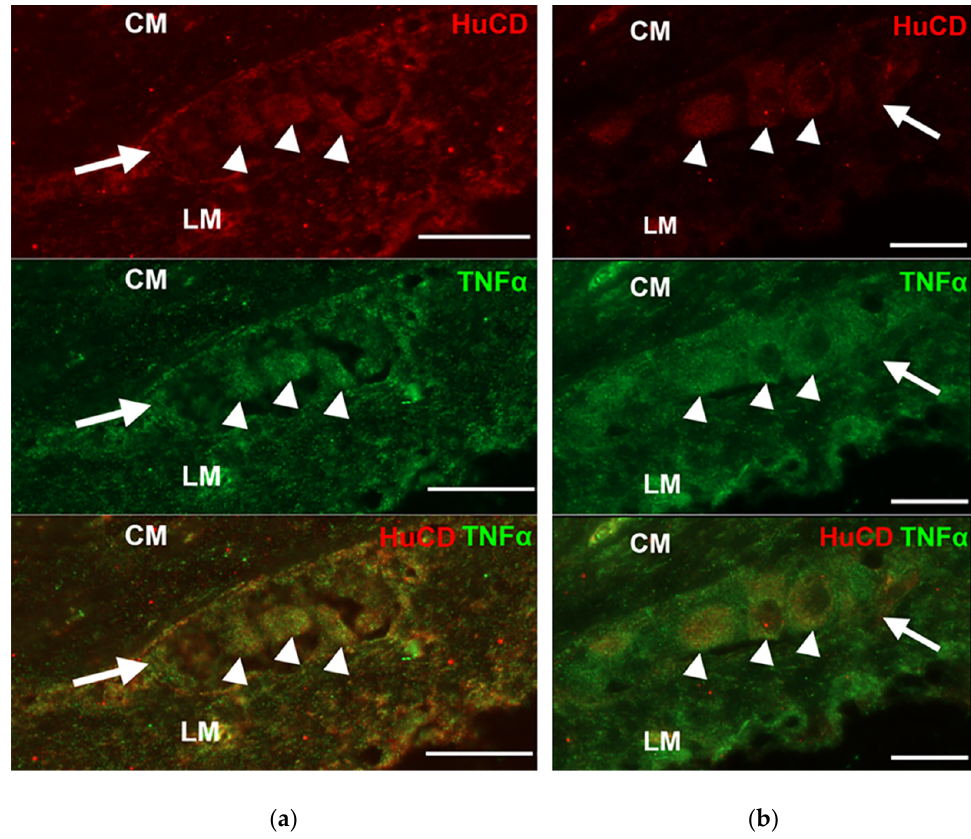
Figure 1. Representative fluorescent micrographs of paraffin sections of myenteric ganglia from the